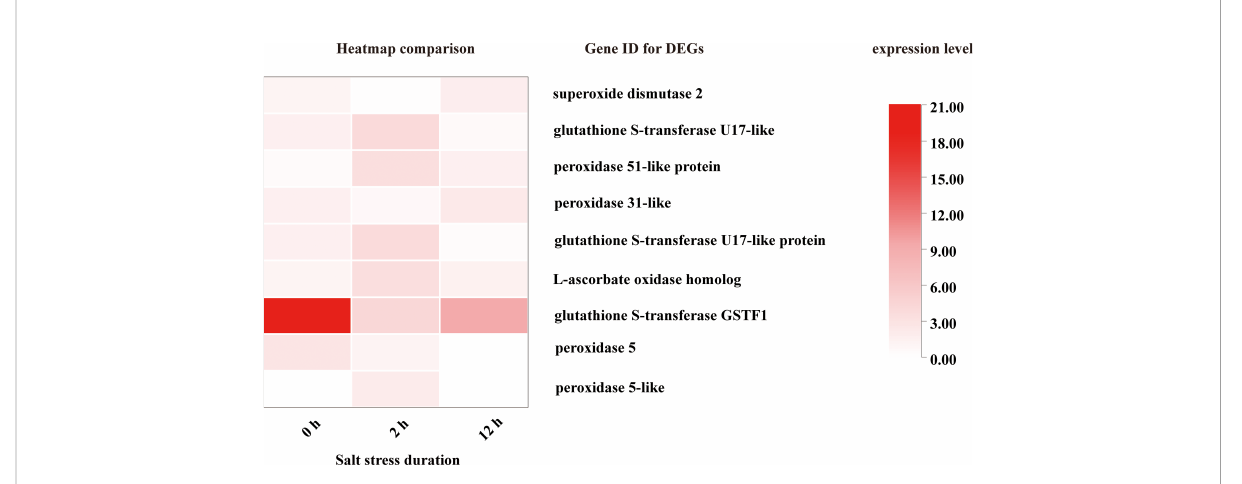
FIGURE 14 DEGs with ROS scavenging activity co-induced at both 0-2 h and 2-12